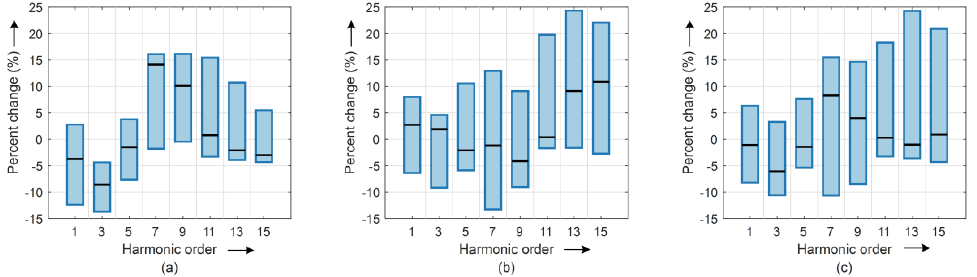
Figure 3. Relative difference in current magnitude between flat-top and sinusoidal supply voltage: ( a ) CFL; ( b ) LED lamps; ( c ) mix.